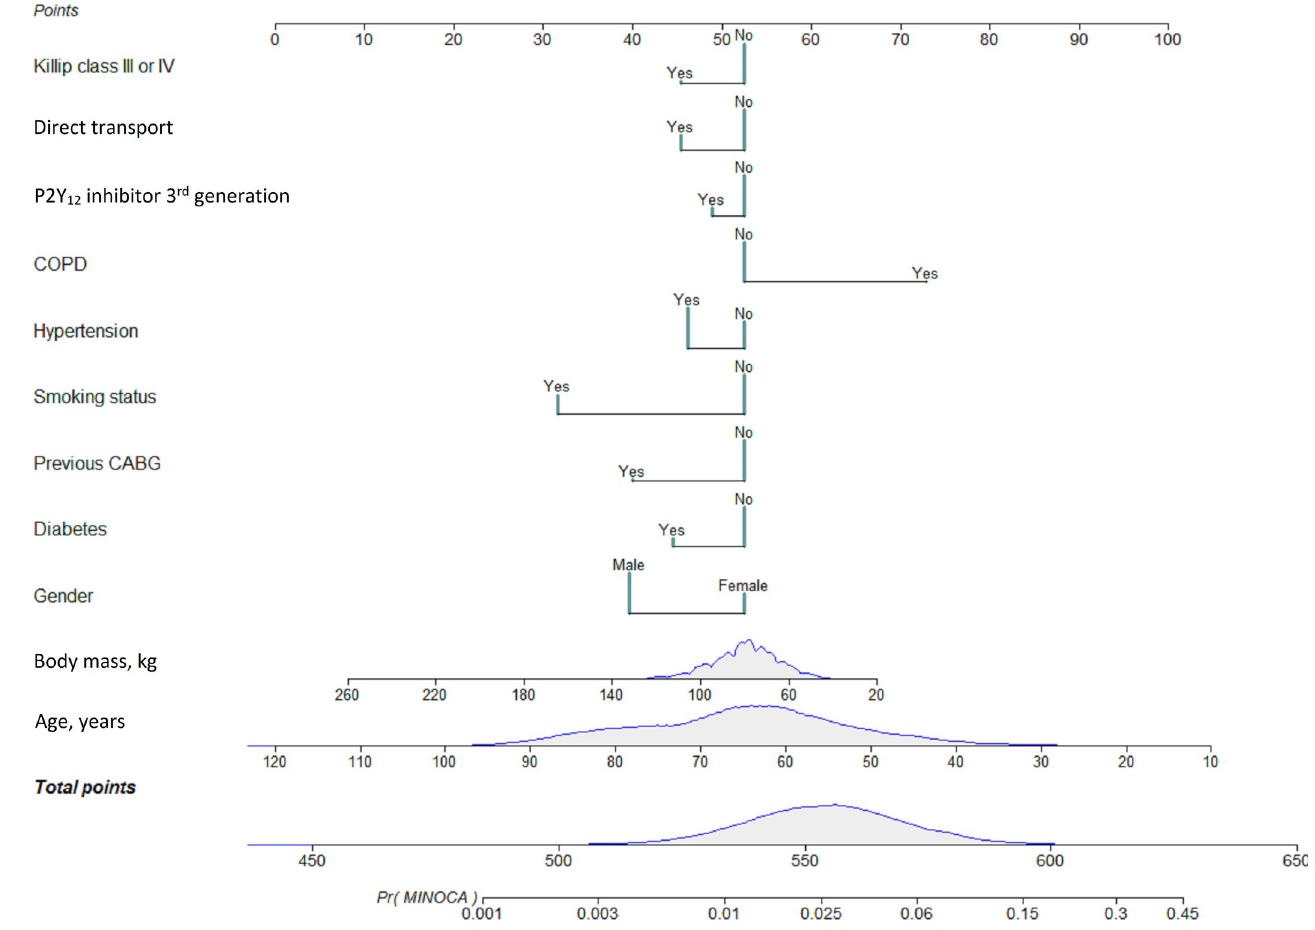
Fig 3. Nomogram for predicting suspected MINOCA among STEMI